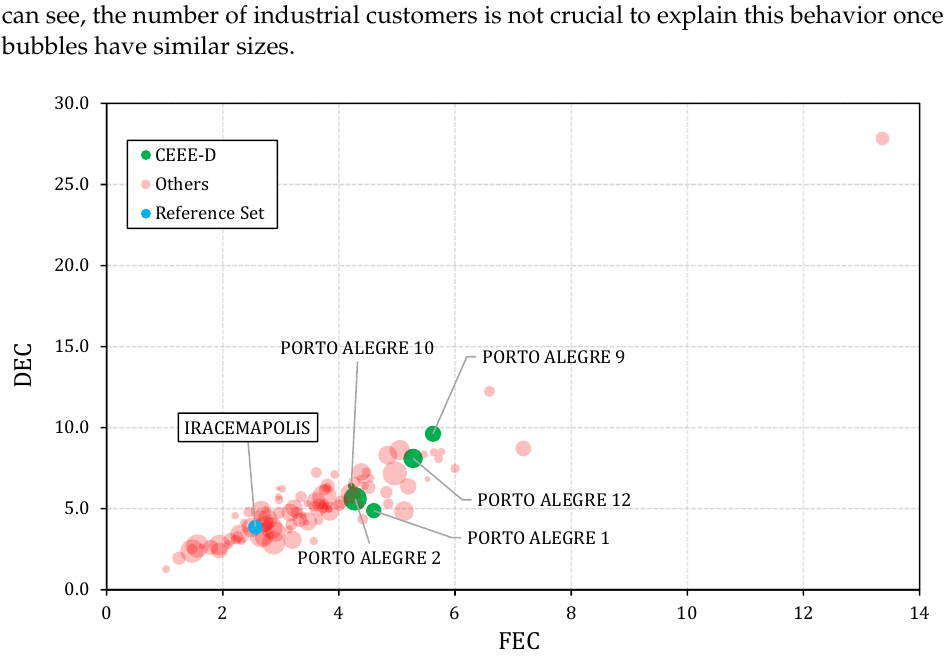
Figure 9. Impact of the NUC_IND attribute on DEC and FEC performance for the cluster of Porto Alegre 1